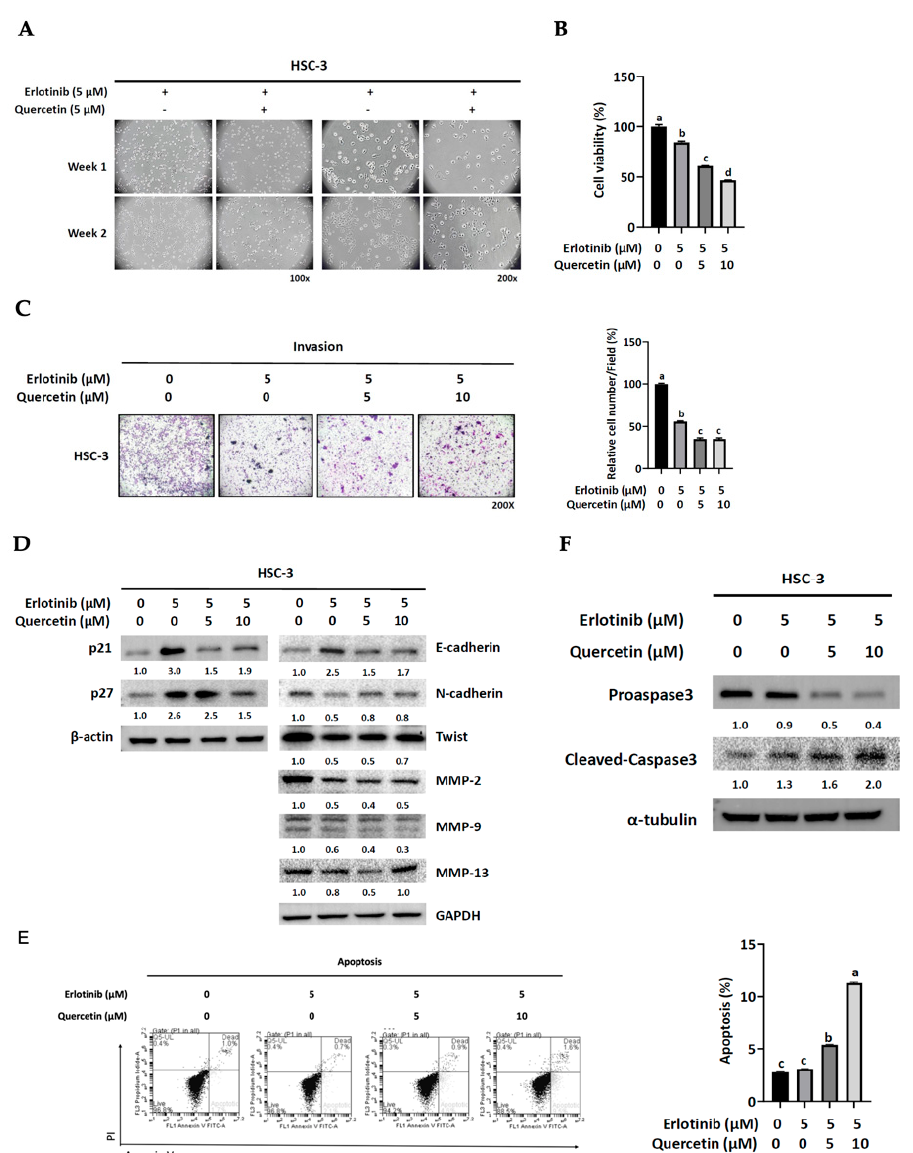
Figure 7. Effect of quercetin on the development of acquired resistance to erlotinib. ( A ) HSC-3 cells were cultured in media containing erlotinib (5 μ M) with or without quercetin (5 μ M) for 2 weeks and photographed under a phase-contrast microscope. ( B – F ) HSC-3 cells were cultured in media containing erlotinib (5 μ M) with quercetin (0, 5, 10 μ M) for 24 h and then subjected to ( B ) an MTT cell viability, ( C ) a Matrigel invasion assay, ( D ) Western blot analysis for protein levels of p21, p27, E-cadherin, N-cadherin, Twist, MMP-2, -9, and -13, and ( E ) a flowcytometric analysis for cell apoptosis and ( F ) Western blot analysis for cleaved-caspase 3 protein expression. Values are mean ± SD, n = 3. abcd Values with different letter differ significantly at indicated time point, p < 0.05.